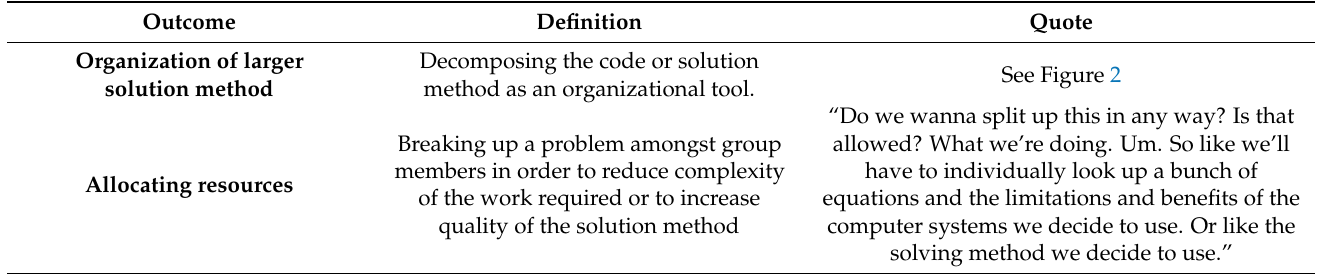
Table 8. Definitions and quotes of CT outcomes identified for decomposition (letters denote individual deidentified